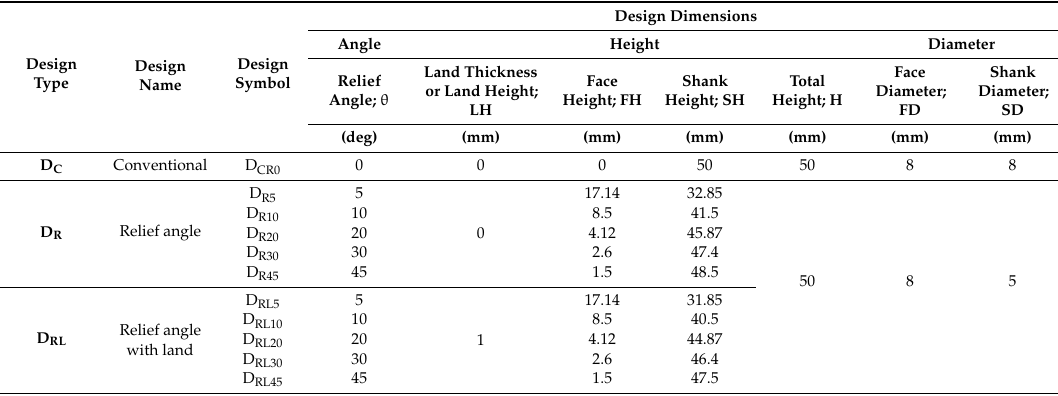
Figure 2. Schematic of electrode designs; ( a ) sub-designs of D R , and ( b ) sub-design of D RL. Table 3. Electrode designs with